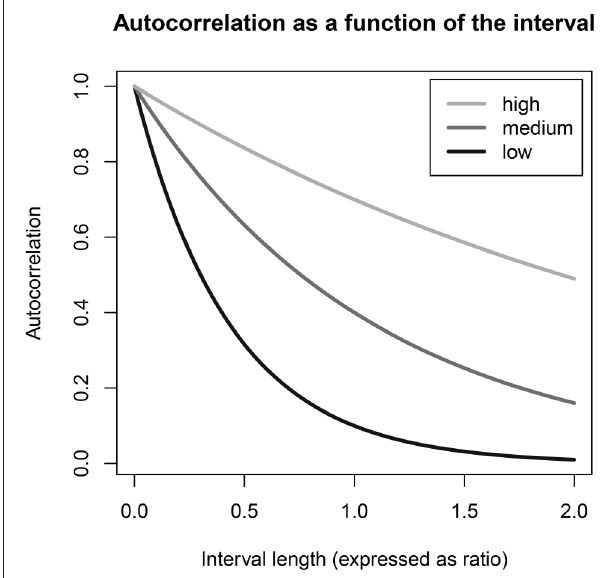
FIGURE 2 | The relationship of the autocorrelation to the (proportionate) interval length 1 , given by φ raised to the power of 1 , is illustrated here for cases where the autocorrelation for a one-block interval is 0.1, 0.4, or 0.7, labeled as low, medium, and high φ parameters, respectively. The interval length is expressed as a ratio of the block length chosen in the study design, such that an interval of 0.5 is half a block and 2.0 is two blocks; and the depicted relationship holds regardless of what amount of time (e.g., 60 or 120 min) is considered to be “one block.” When the autocorrelation for a one-block interval is low to medium, shorter and longer time intervals in an empirical data set cannot be expected to cancel each other out exactly in the estimation of φ